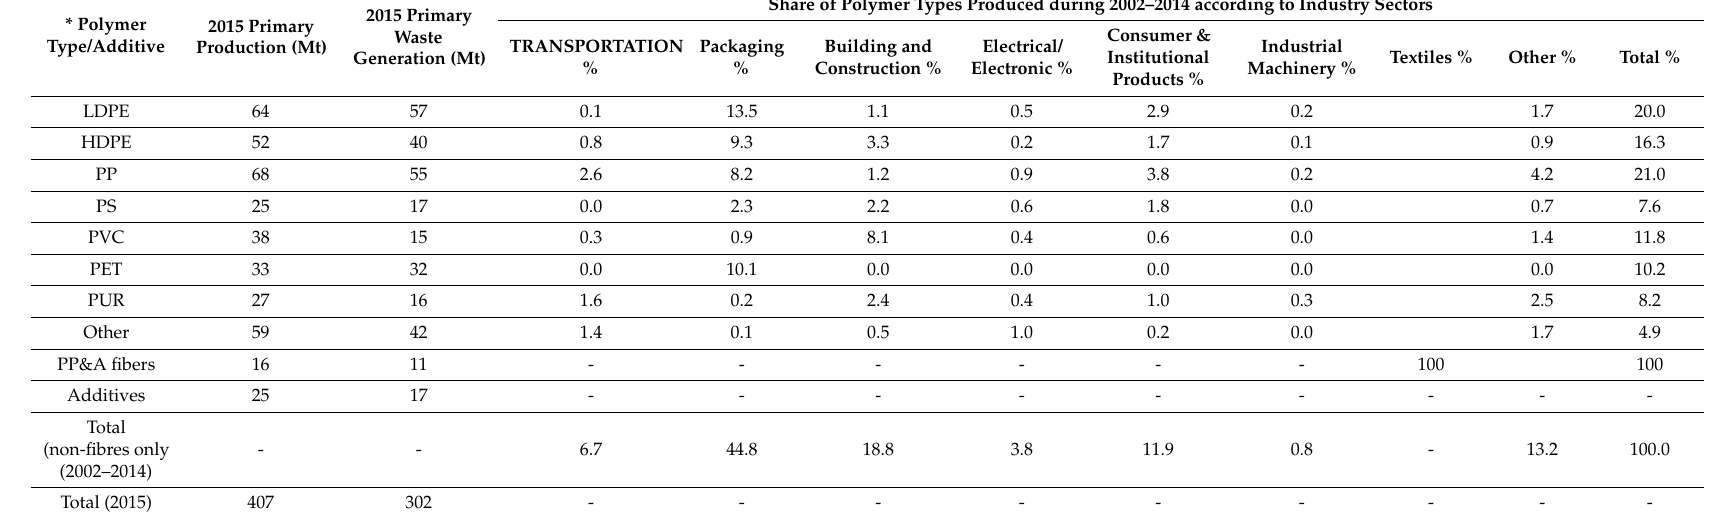
Table 2. Share of polymer types produced according to industrial sector (2002–2015)